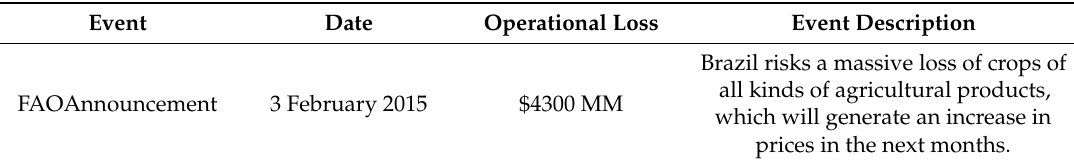
Table 2. Event description. Source: LexisNexis ®